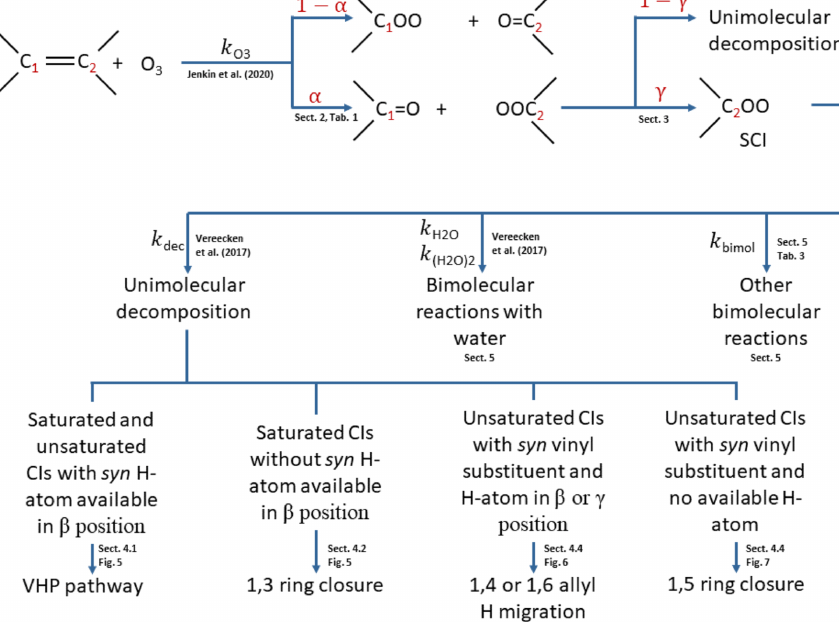
Figure 2. Flow diagram for implementation of the protocol. α : branching ratios in POZ decomposition; γ : fraction of CI stabilised. > COO denotes the Criegee intermediate formed.